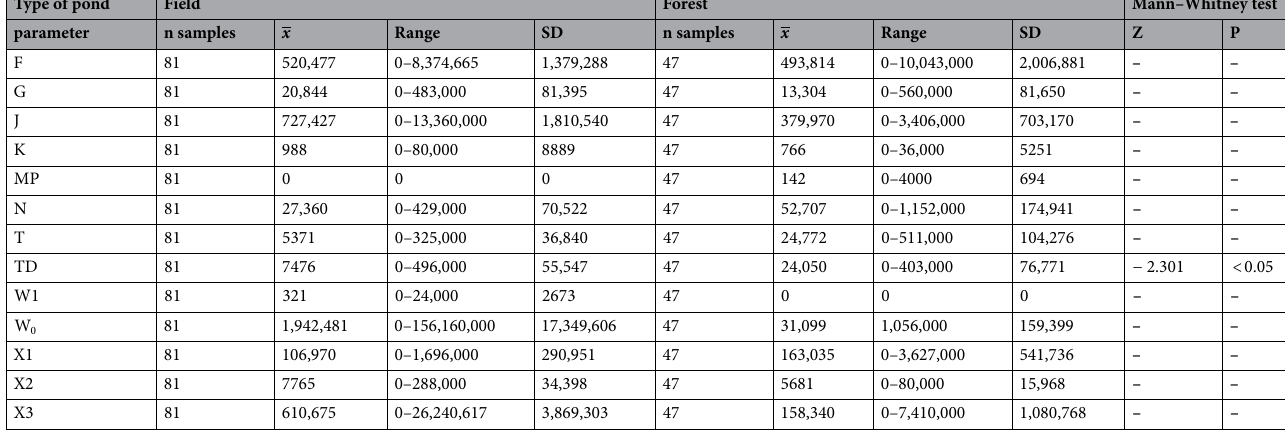
Table 5. Abundance of each chlorophyte functional group (ind l −1 ) in different pond types (field vs. forest). The results of Mann–Whitney test are given.